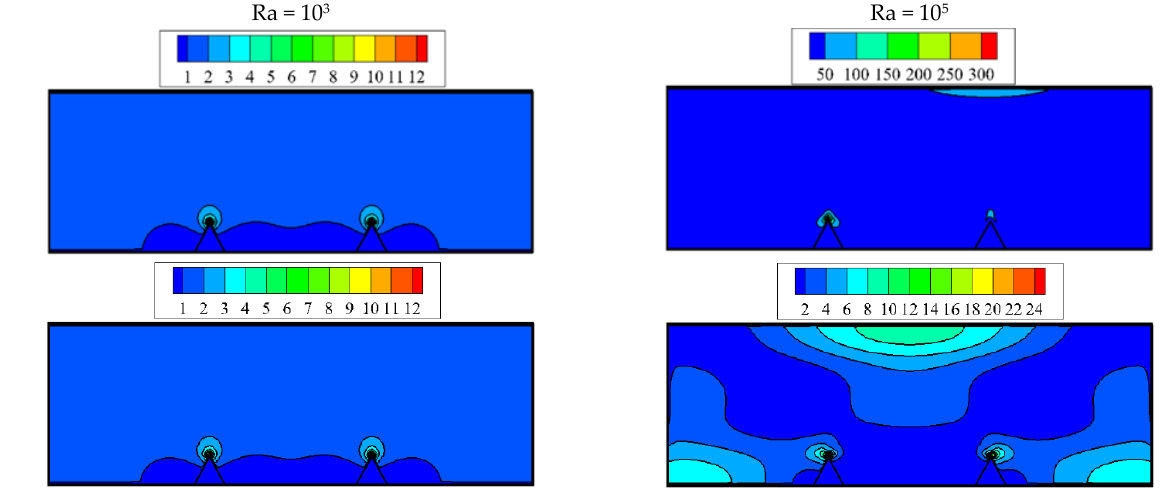
Figure 4. The effect of Ra and Ha on the temperature field for H = W = 0.2 and a volume fraction of 0.3%. Figure 5 shows the effect of Ra and Ha on the EGN for H = W = 0.2 and a volume fraction of 0.3%. At low Ra. The variations of the Ha do not affect the place of EGN and the values of EN. However, at Ra = 10 5 , the Ha affects the place of EGN and the values of EN. High EGN occurs at the blade tip in all figures. Numerical values for Ra = 10 5 and the absence of the M-F are much larger than the other cases.